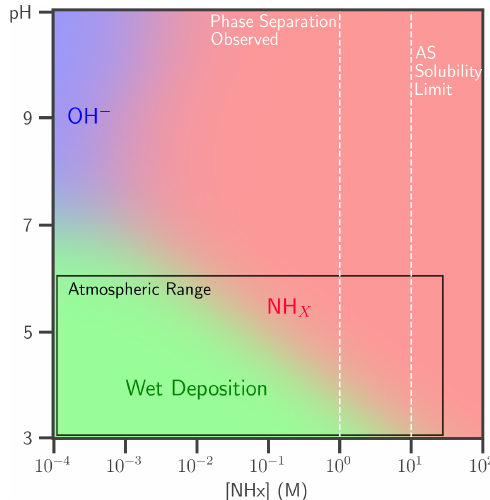
Figure 4. The dominant butenedial loss pathway, reaction with OH − (blue) or NH x (red) and wet deposition (green), is shown as a function of pH and NH x . AS is the NH x source. Loss via wet deposition is considered to have a 1-week lifetime, typical of at- mospheric particles. The range of pH (3–6) and NH x concentration ( < 28M) relevant to the atmosphere is overlaid on the plot, as well as the NH x concentrations at which phase separation in the mixtures was observed and the AS solubility